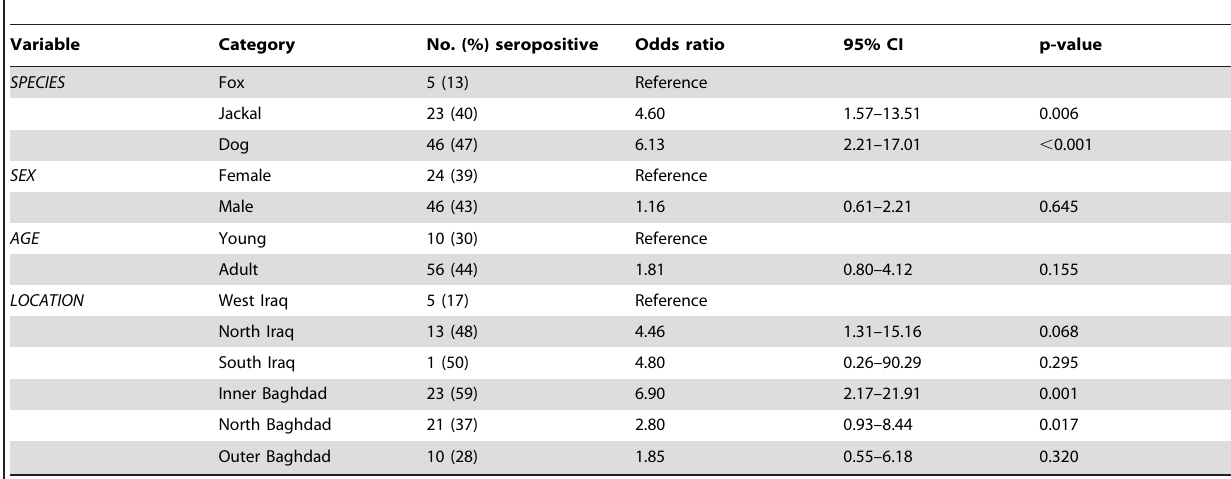
Table 6. Univariate analysis* of factors associated with Bartonella serostatus in Iraqi canids.